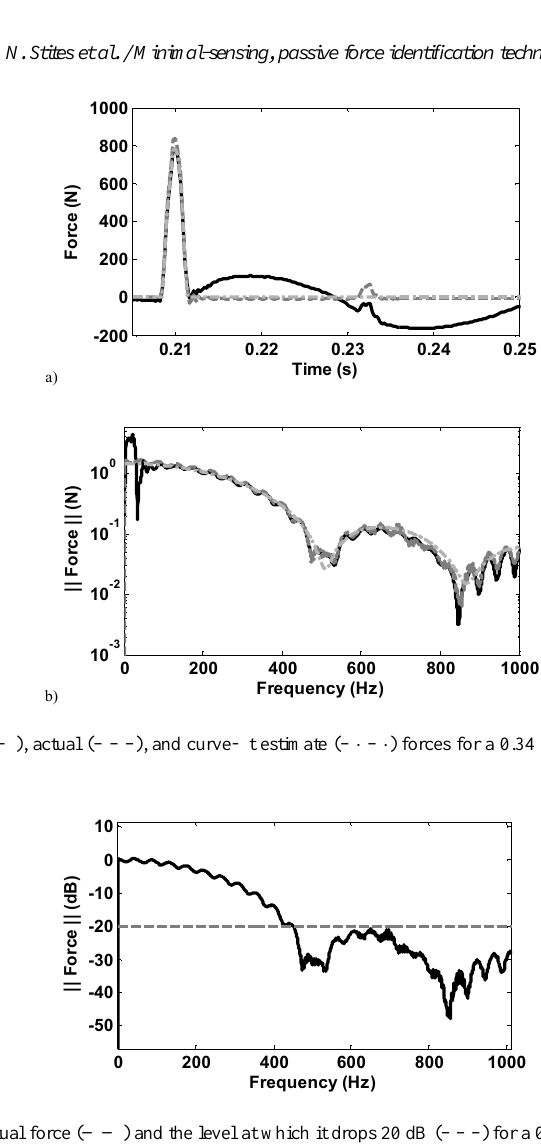
Fig. 22. The actual force (——) and the level at which it drops 20 dB (– – –) for a 0.34 J impact